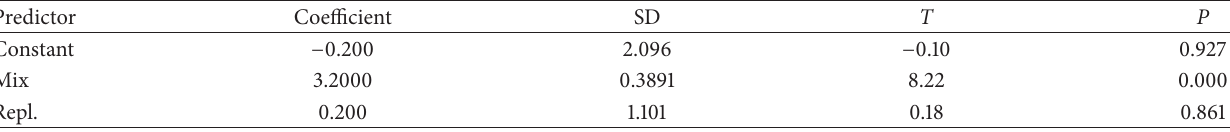
Table 11: Regression analysis on V-Funnel time.